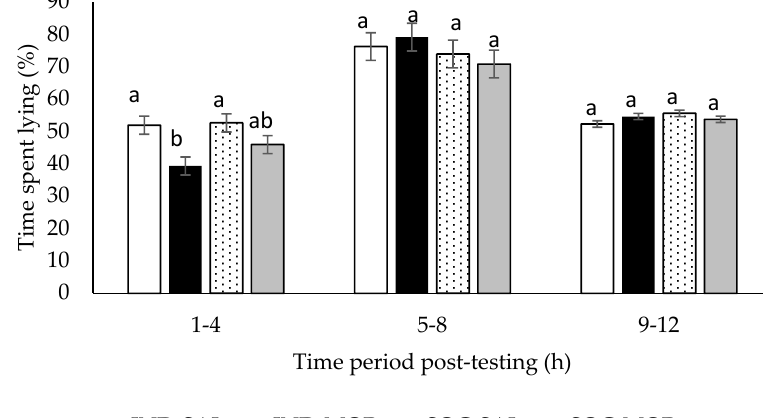
Figure 4. Total social play events (%/5 min; Least square means ± SEM) performed by calves during a 20 min observation period in an arena test. Calves received an injection of saline (SOC-SAL, n = 12) or received an injection of morphine (SOC-MOR, n = 12). * Least square means differ at p < 0.10. Individually tested calves that received morphine spent less ( p < 0.05) time lying than individually tested calves that received saline during the first 4 h after returning to the home pen ( F (3,29) = 4.91, p = 0.007; Figure 5). During the first 4 h after returning to the home pen, calves given morphine spent less time lying than calves given saline (lying (%/1–4 h post-testing): SAL: 52.4 ± 1.97; MOR: 42.7 ± 1.97, F (1,29) = 11.534, p = 0.002), but there was no difference in lying times between calves tested individually or in pairs (lying (%/1–4 h post-testing): IND: 45.7 ± 1.97; SOC: 49.4 ± 1.97, F (1,29) = 1.704, p = 0.202). There was no difference ( p > 0.05) in lying times among treatments during the 5 − 8 or 9 − 12 h post-test periods.